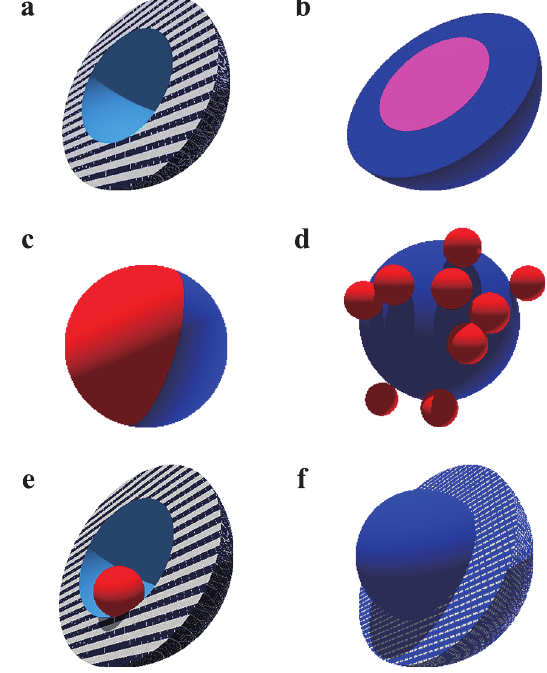
Fig. 1 Examples of structured particles: (a) hollow particle, (b) core- shell particle, (c) Janus particle, (d) raspberry-like (core-satellite) parti- cle, (e) yolk-shell particle, (f) superficially porous